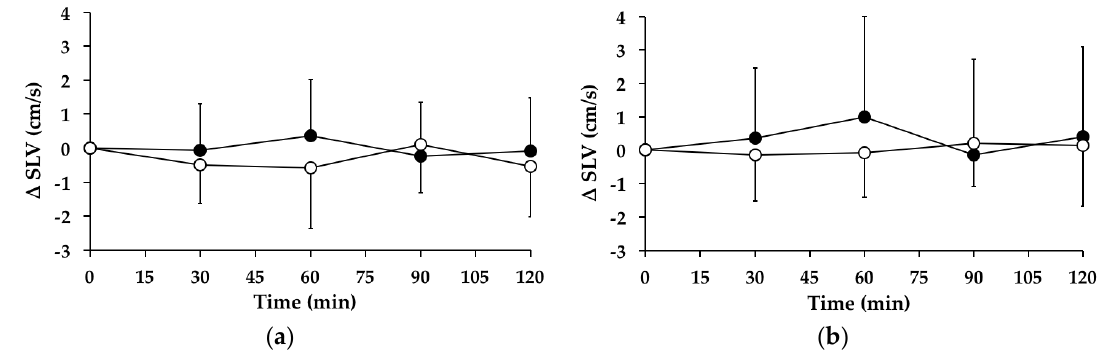
Figure 4. Mean change ( (cid:52) ) in stride length variability (SLV) on “WW” ( ) and “GW” ( ) days in subjects: ( a ) with postprandial hypotension (PPH); and ( b ) without PPH. Data are mean ± standard deviation (SD) represented by vertical bars.